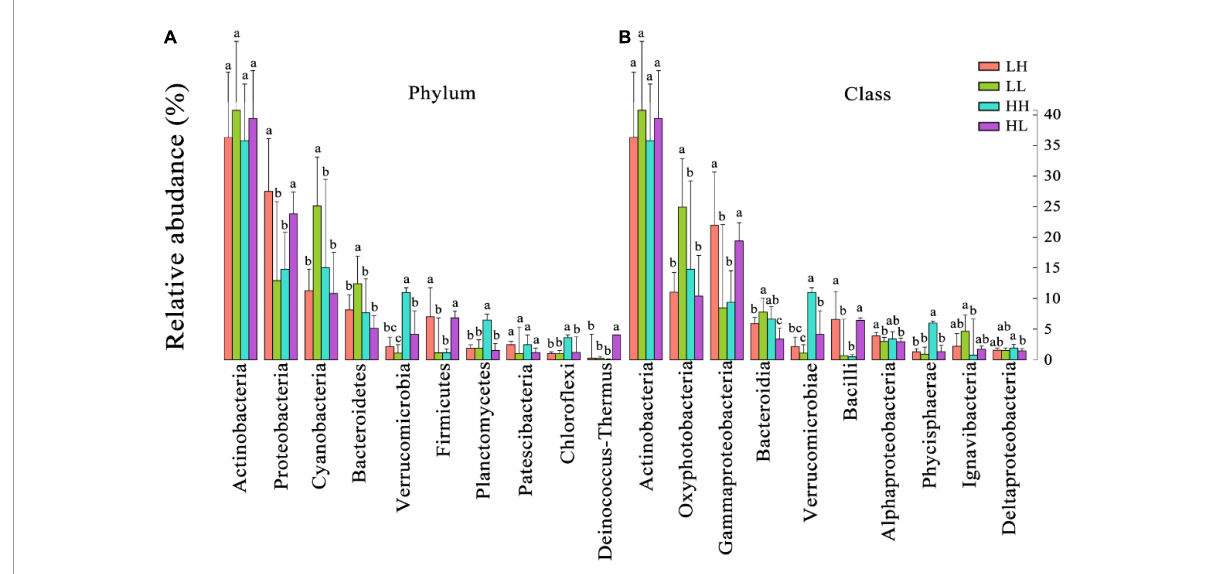
FIGURE5 The relative abundances of the 10 most abundant bacteria at the (A) phylum and (B) class levels in freshwater of the four wetlands. Different superscripted lowercase letters indicate p < 0.05.